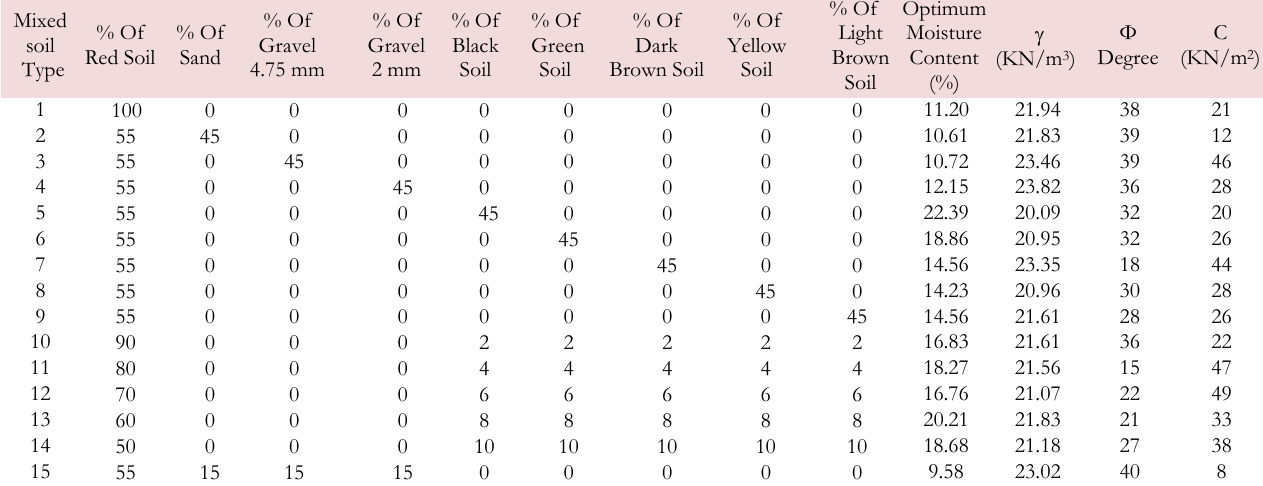
Table 1: The mixed soil design and characteristics